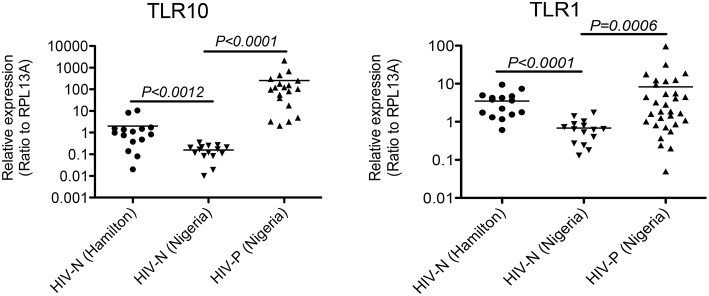
Significantly elevated expression level of TLR1 and TLR10 in HIV-1 infected human primary BM cells. Expression of TLR1 and TLR10 as measured by qRT-PCR with the mRNA extracted from primary BM cells collected from HIV-1 negative Hamilton, Canada women (HIV-N Hamilton) and Nigerian HIV-1 negative (HIV-N) and HIV-1 positive (HIV-P) women. TLR1 expression is shown on right (p = 0.0006) whereas TLR10 expression is shown on left (p < 0.0001).